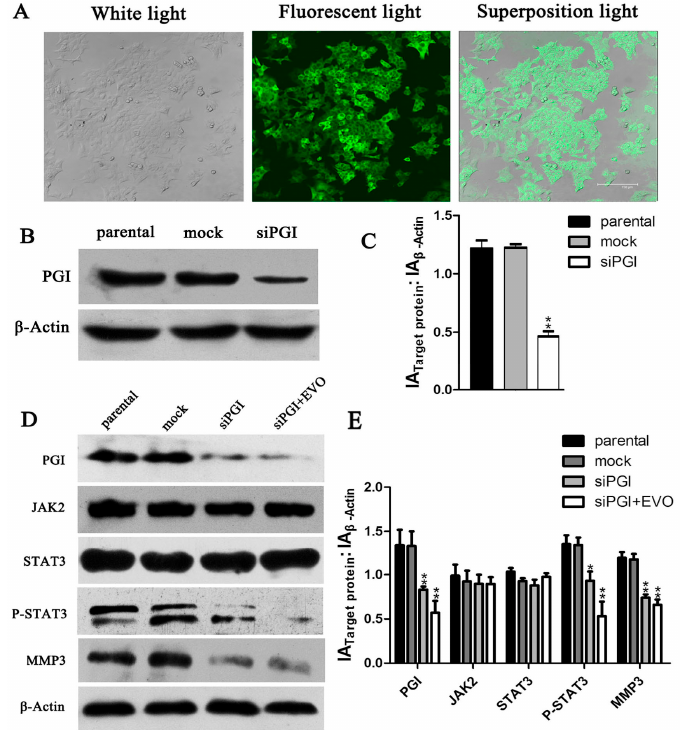
Figure 5. Expression of PGI, MMP3, and p-STAT3 in siPGI (HCT-116) cells. ( A ) Stably transfected siPGI (HCT-116) cells were screened (original magnification, 800×); ( B ) PGI expression in the stable cell line siPGI (HCT-116) was analyzed by Western blotting; ( D ) siPGI (HCT-116) cells were treated with 6 μ mol/L EVO for 6 h, and proteins were subjected to Western blot analysis; ( C , E ), The graph represents the densitometry of the results of three independent experiments (mean ± SD), * p < 0.05, ** p < 0.01, versus the parental group.